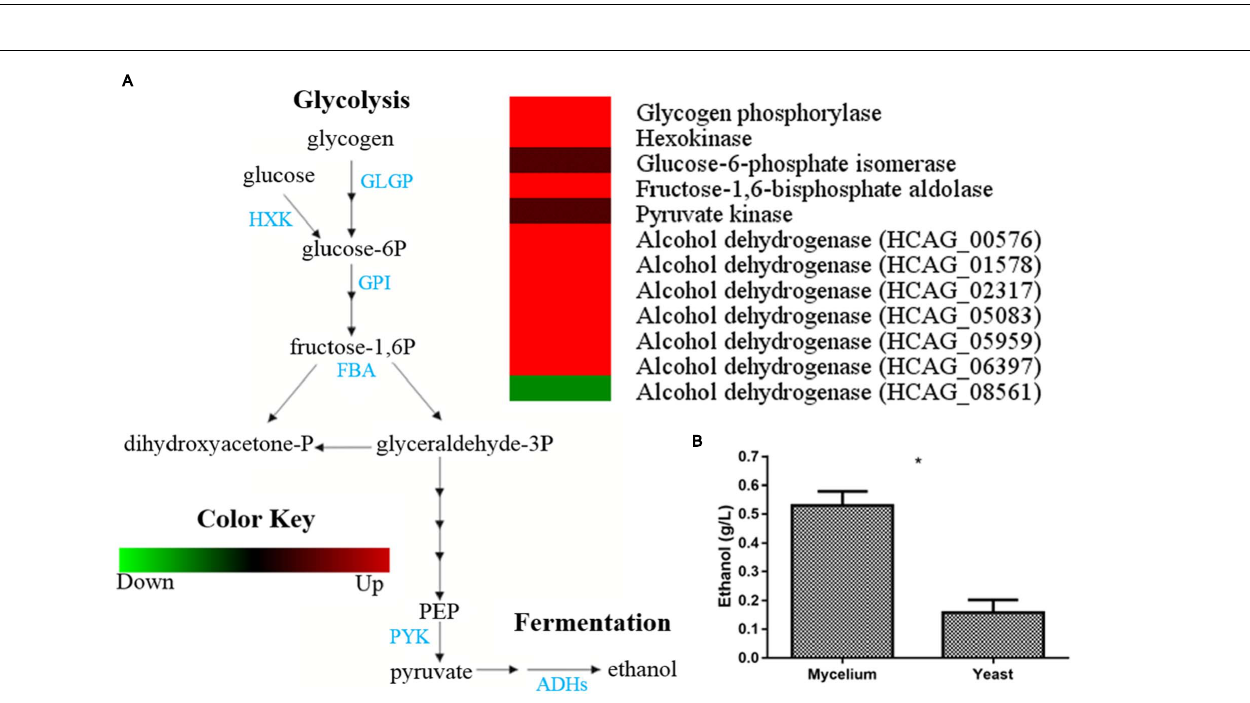
FIGURE 2 | Comparison of protein profiles related to glycolysis and fermentation in H. capsulatum mycelium and yeast forms. A 50%-fold change was used as a cutoff to determine the differentially abundant proteins in the fungus yeast and mycelial forms. The Multi Experiment Viewer software V.4.9 was used to group and compare the abundance data. (A) The diagram representing the glycolytic and fermentation metabolic pathways represents differentially abundant proteins in the mycelium and yeast phases. Changes in the abundance levels in the mycelium compared with the yeast are represented in the heat map. Experimental triplicate mean values are presented for the lowest abundance (green) and the H. capsulatum proteins highest abundance (red) in the mycelium form. Black indicates that no significant difference was observed. GLGP, glycogen phosphorylase; HXK, hexokinase; GPI, glucose-6-phosphate isomerase; FBA, fructose-1,6-bisphosphate aldolase; PYK, pyruvate kinase; ADHs, alcohol dehydrogenases. (B) Ethanol quantification assay. The ethanol concentration (g/L) was determined in H. capsulatum yeast and mycelial phase cells, upon growth in Hams F12 media for 72 h (36 ◦ C) and 96 h (25 ◦ C), respectively. The cells were disrupted in the bead beater, and the ethanol compound was quantified using an enzymatic detection kit (UV-test for ethanol, RBiopharm, Darmstadt, Germany). Data are expressed as the mean ± standard deviation of biological triplicates in independent experiments. * p < 0.05.